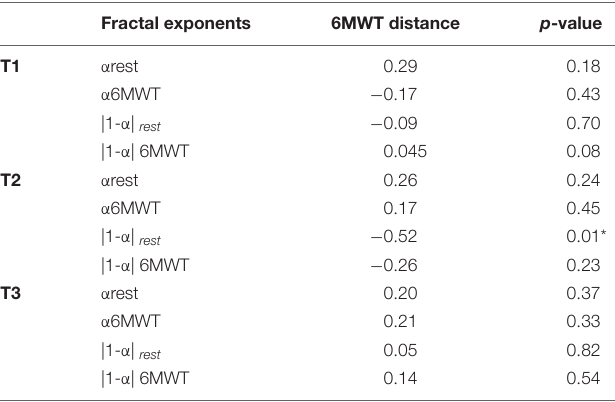
TABLE 3 | Linear correlation coefficients ( r ) between fractal exponents at rest and during the 6MWT and 6MWT distance, throughout the pulmonary rehabilitation